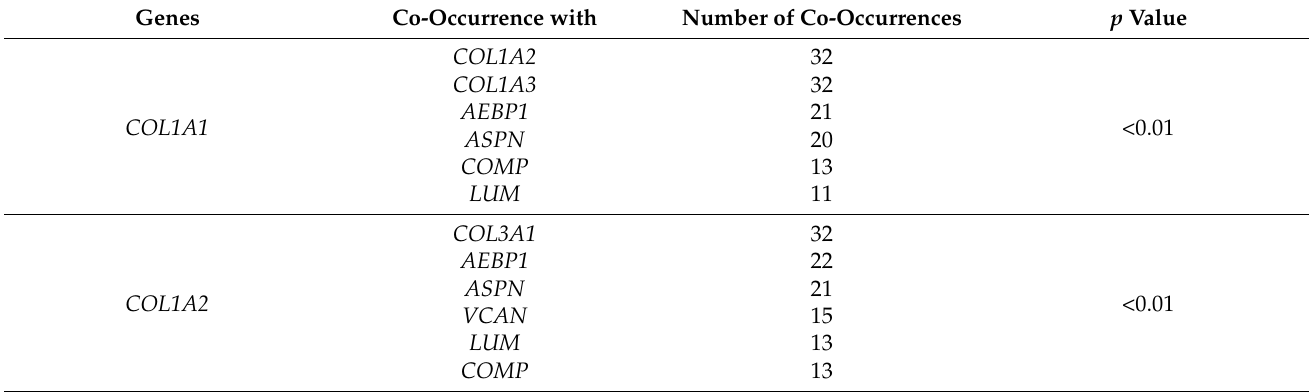
Table 3. Significant co-occurrence in significant expression modification of the connective tissue genes in patients with our queried genes’ expression